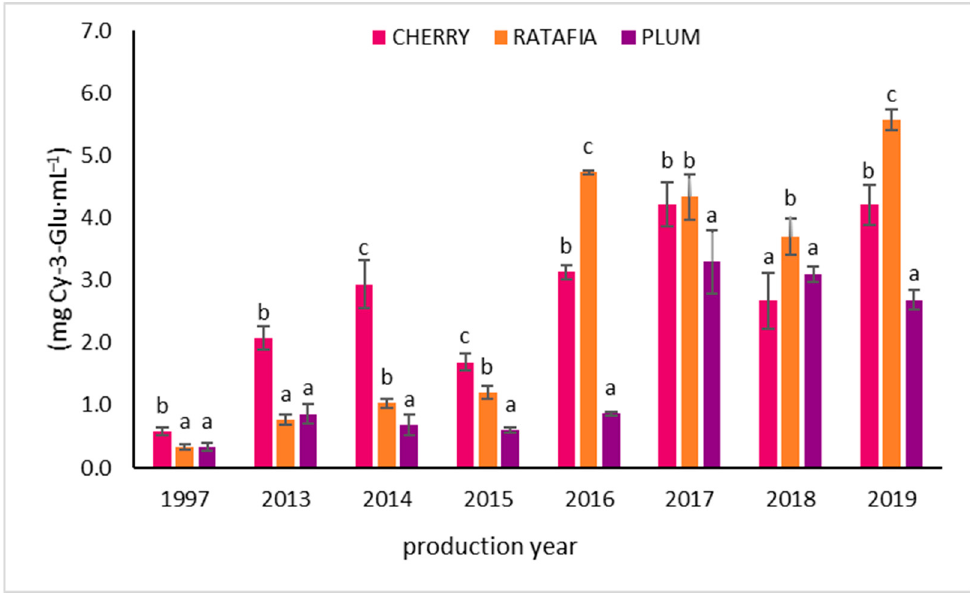
Figure 5. The anthocyanin content of nalewkas (Mean ± SD, n = 3). Different letters indicate significant differences between the nalewkas in individual years of production ( α = 0.05). The result was expressed in mg Cy-3-Glu·mL − 1 of nalewka; Cy-3-Glu—cyjanidin-3-glucoside.